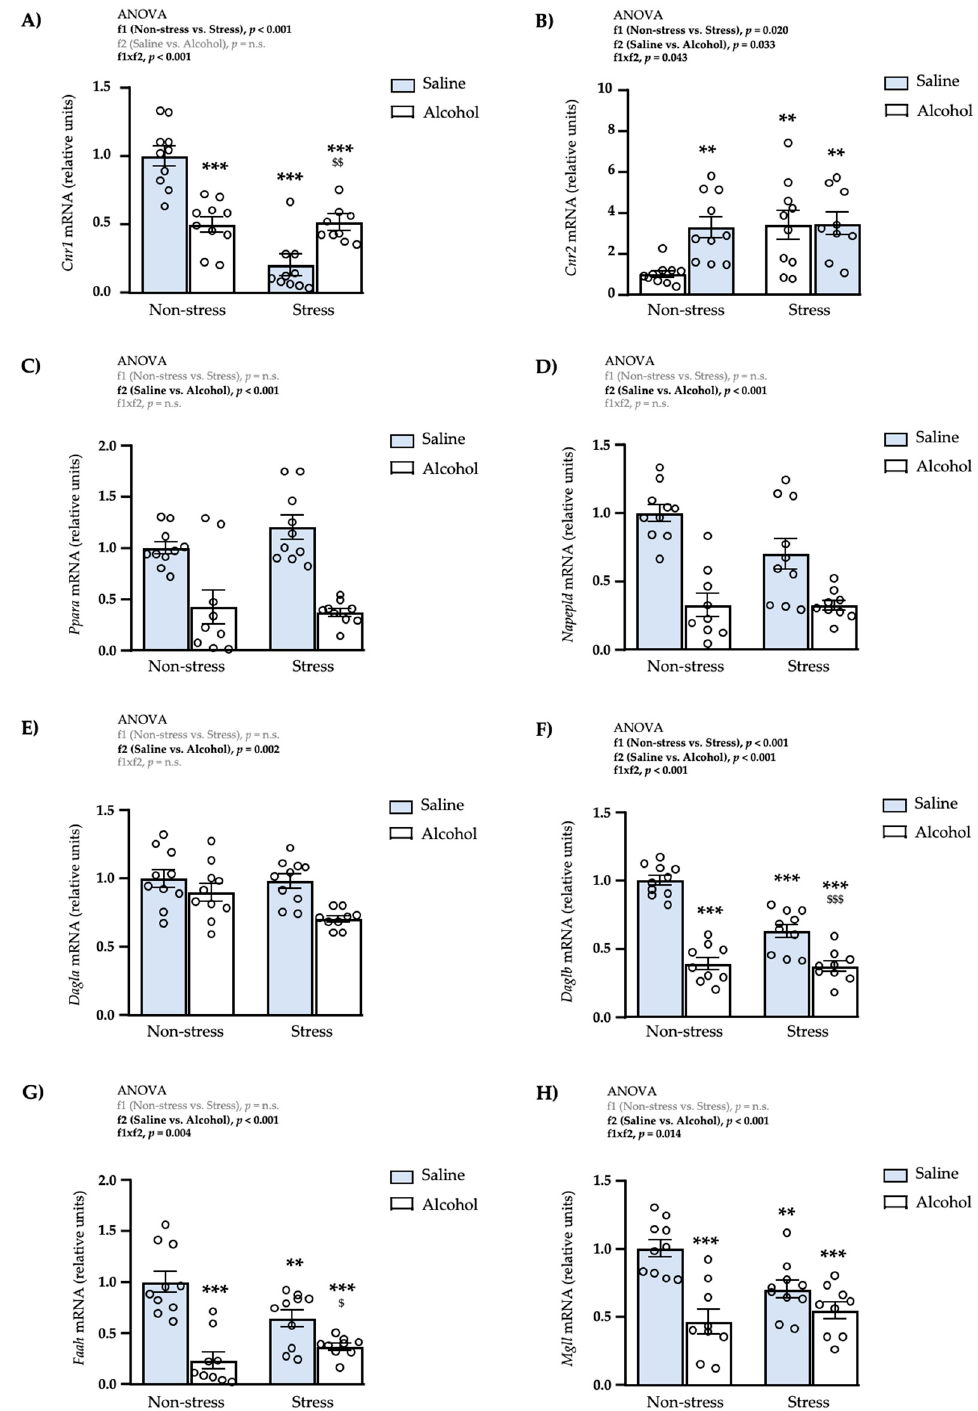
Figure 4. Relative mRNA expression levels of endocannabinoid-signaling genes in the amygdala of adult male rats after repeated restraint stress and/or intermittent alcohol exposure during adolescence. Relative mRNA expression of Cnr1 ( A ); Cnr2 ( B ); Ppara ( C ); Napepld ( D ); Dagla ( E ); Daglb ( F ); Faah ( G ); and Mgll ( H ) in male adult rats after repeated restraint stress (f1) and/or intermittent alcohol exposure (f2) during adolescence. Bars represent the mean ± SEM (9–10 rats/subgroup). Data were analyzed by two-way ANOVA. (**) q < 0.01 and (***) q < 0.001 denote significant differences compared with the non-stress saline subgroup, and ( $ ) q < 0.05, ( $$ ) q < 0.01 and ( $$$ ) q < 0.001 denote significant differences compared with the stress saline subgroup using post hoc tests for multiple comparisons when an interaction between factors is found (f1 × f2). p -values in bold denote significant main effects of factors (f1 and f2) or significant interaction (f1 × f2).